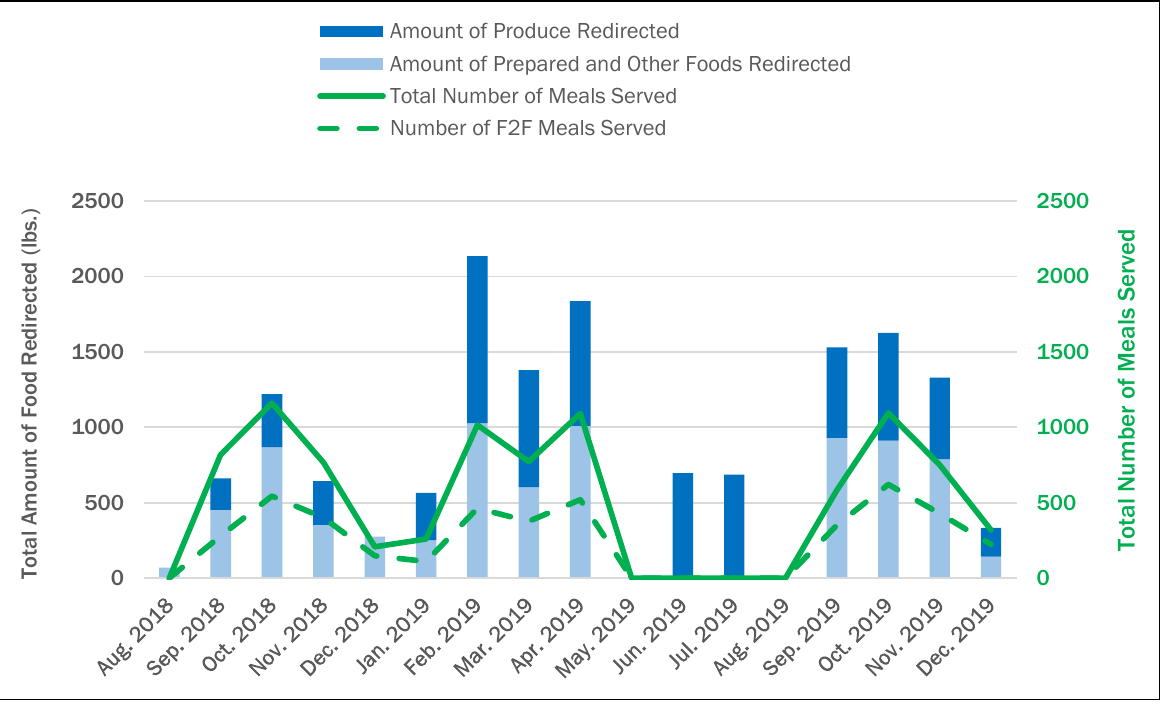
Figure 3. Prepared and Other Foods Recovered Stacked with Produce Recovered Trended over Total Number of Meals Served and Number of Farm-to-Fork (F2F) Meals Served over an 18-month